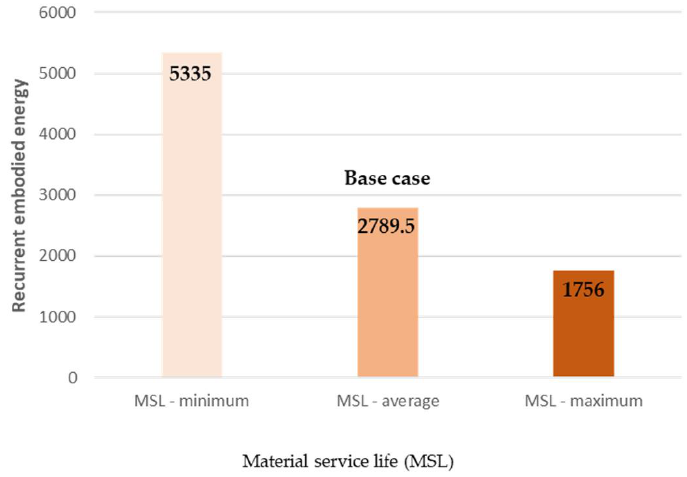
Figure 4. Recurrent embodied energy of the case study house with the minimum, average and maximum material service life over 50 years.